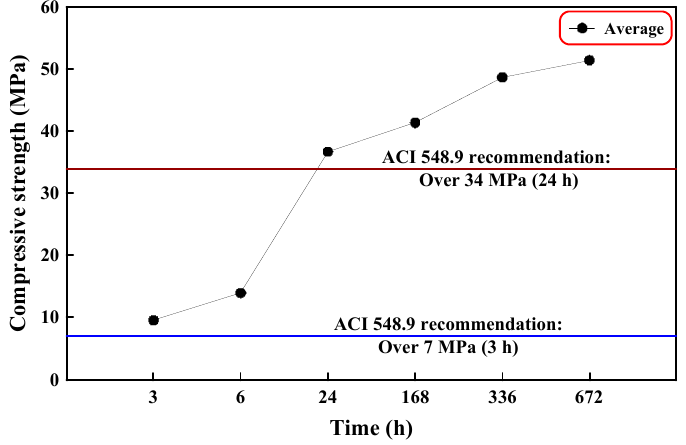
Figure 4. Effect of curing time on average compressive strength.